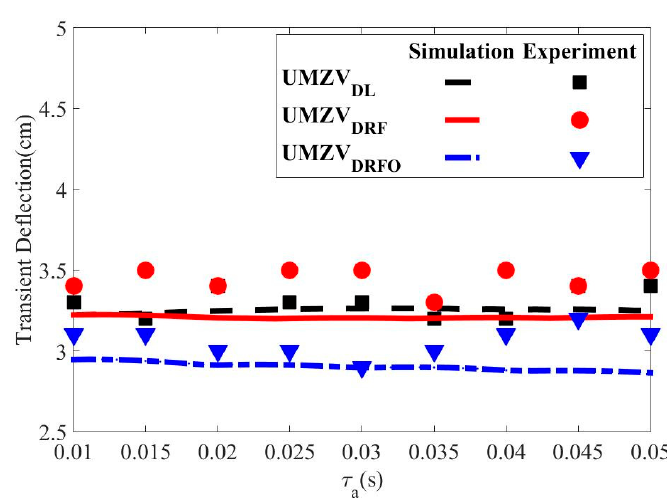
/ τ . Figure 18. Experimental sensitivity to τ a a m . (cid:3288)